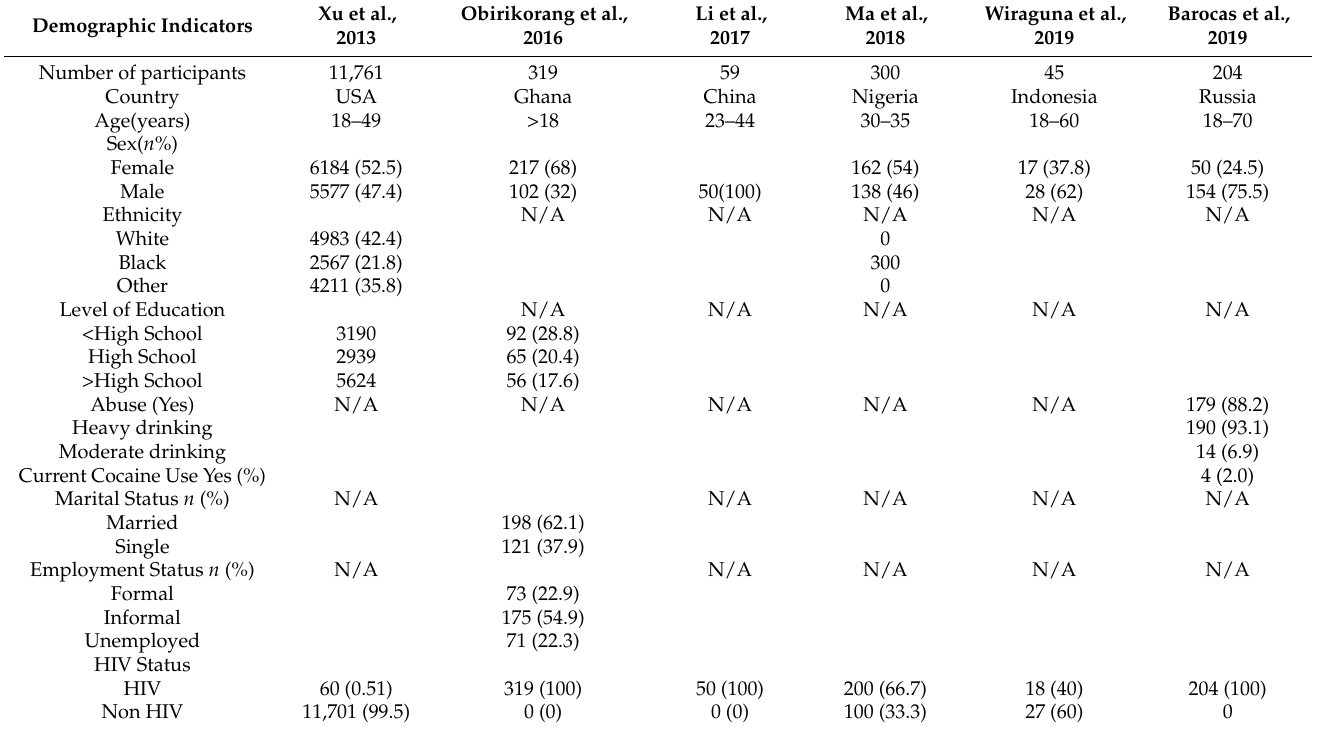
Table 1. Demographic Characteristics of Patients in Each